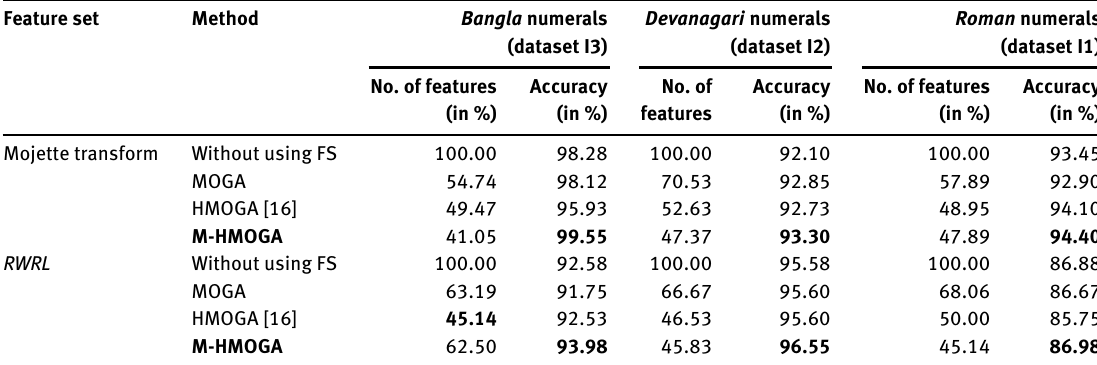
Table 7: Comparison of the Proposed FS Model Called M-HMOGA for Two Feature Sets with HMOGA and MOGA Using MLP as the Classifier in E1 (Best Results Are Made Bold).